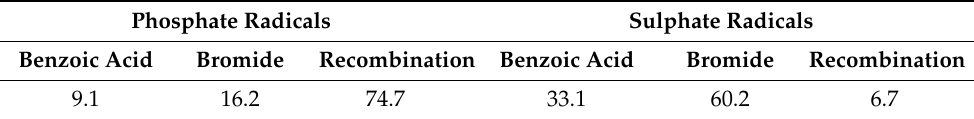
Table 2. Fraction of phosphate/sulphate radicals (%) reacted with benzoic acid (24 µ M), bromide (15 µ M) and its